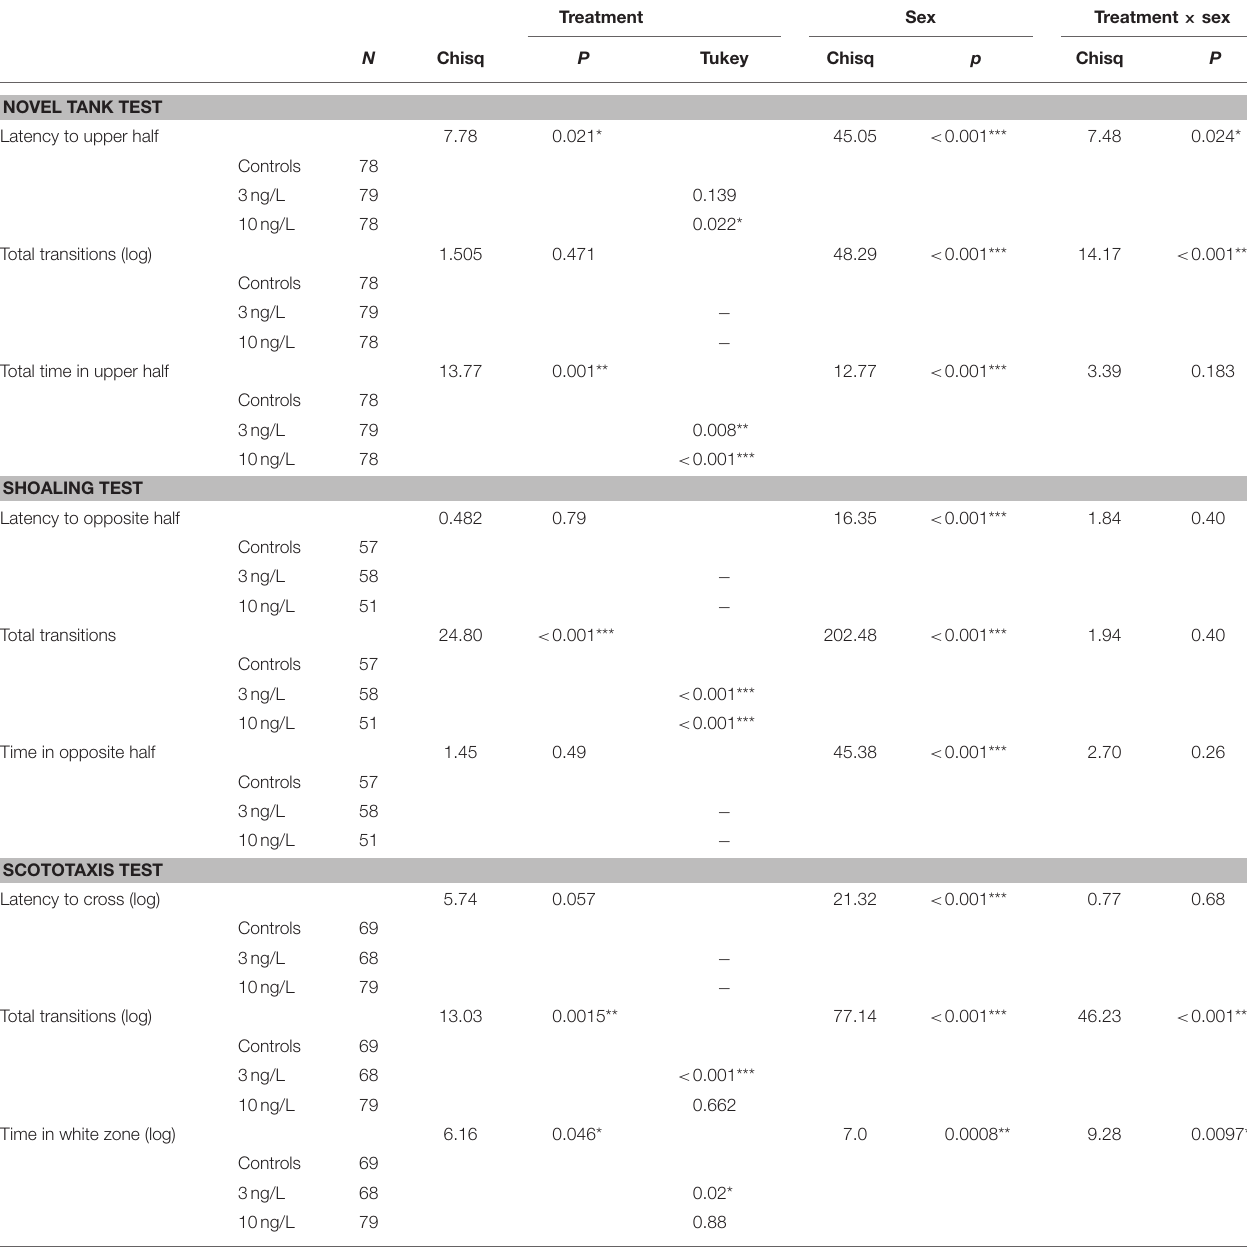
TABLE 3 | Results from behavior tests with mixed effects models following Tukey multiple comparison test when significant treatment effect. Treatment vs. controls analyzed with Tukey